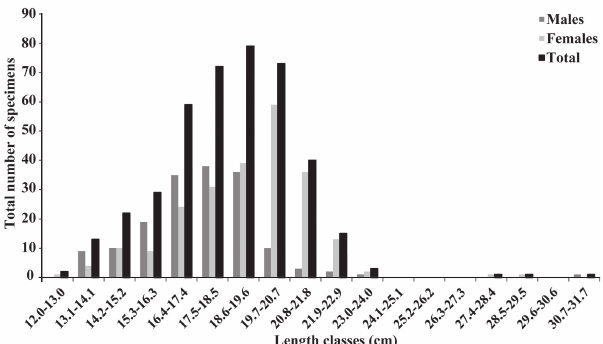
Fig. 2. Distribution by length classes for separate sexes and grouped sexes of Loricariichthys melanocheilus in the rio Ibicuí, Rio Grande do Sul.